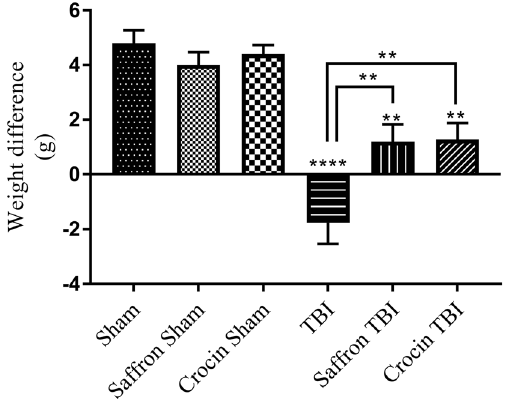
Figure 1. The weight difference between day 0 and day 14. Data are mean ± SEM of 25 mice per group. TBI group showed a negative difference (p < 0.0001). Both saffron TBI group and crocin TBI showed a positive difference (p <